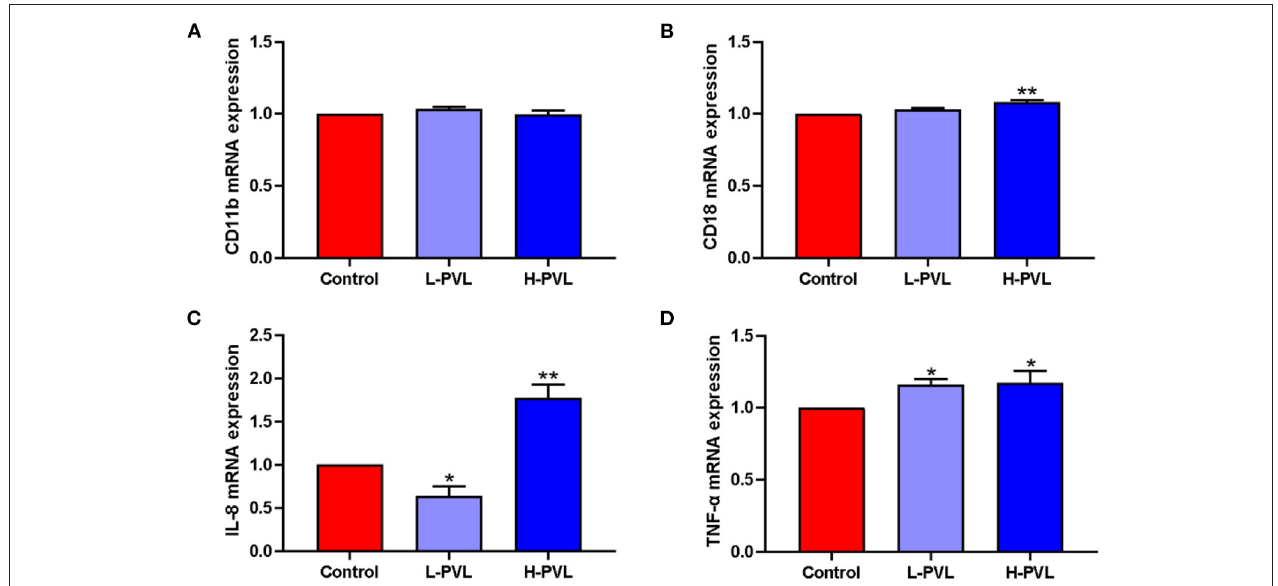
FIGURE 6 | Effect of BLV infection on the mRNA expression of PMN adhesion molecules CD11b, CD18, and inflammatory factors IL-8, TNF- α . (A) Effect of BLV infection on CD11b mRNA expression, (B) Effect of BLV infection on CD18 mRNA expression, (C) effect of BLV infection on IL-8 mRNA expression, and (D) Effect of BLV infection on TNF- α mRNA expression. * P < 0.05 compared to healthy cows, ** P < 0.01 indicates significant difference compared to healthy